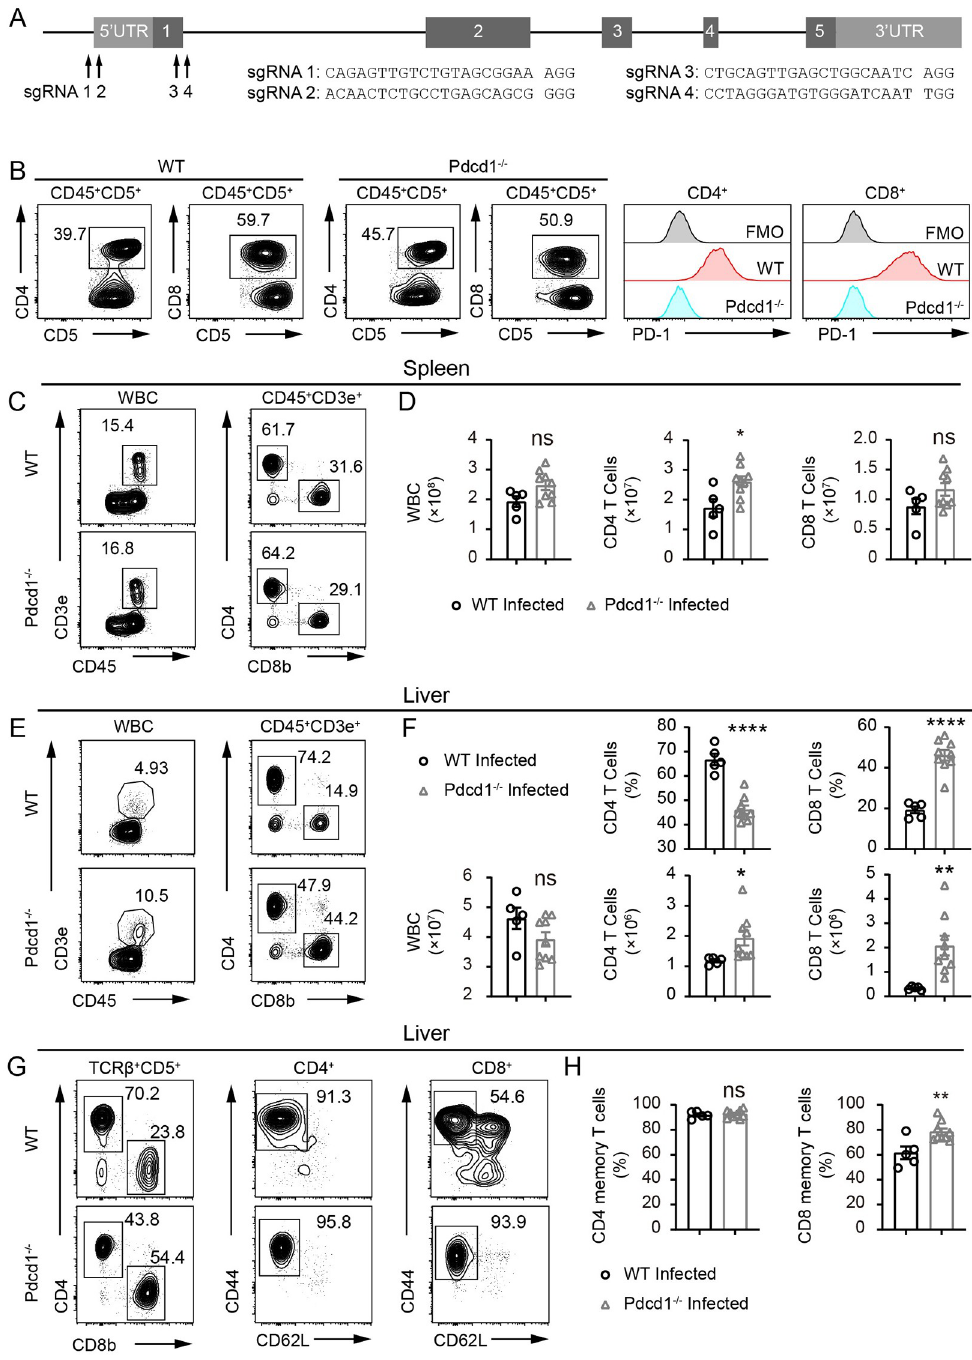
Fig 2. Increase of T cell presence in the liver of PD-1-deficient mice infected with S . japonicum for 8 weeks. (A) sgRNA design to target Pdcd1 gene in C57BL/6 mice using CRISPR/Cas9 genome editing tool. (B) Flow cytometric analyses of PD-1 expression in T cells from peripheral blood of both WT and PD-1-deficient mice following 72 h treatment with anti- CD3 (3 μ g/mL) and anti-CD28 (1 μ g/mL) antibodies. (C-D) Flow cytometric analyses of WBCs, and T cells including CD4 + and CD8 + T cells in the spleen of WT and PD-1-deficient Pdcd1 −/− mice infected with S . japonicum for 8 weeks (WT mice, n = 5; KO mice, n = 9). (E-F) Flow cytometric analyses of WBCs, and T cells including CD4 + and CD8 + T cells in the livers of WT and PD-1-deficient Pdcd1 −/− mice infected with S . japonicum for 8 weeks (WT mice, n = 5; KO mice, n = 9). (G-H) Flow cytometric analyses of memory T cells in CD4 + and CD8 + T cell subsets in the livers of WT and PD- 1-deficient mice infected with S . japonicum for 8 weeks (WT mice, n = 5; KO mice, n = 9). Data represent the mean ± s.e.